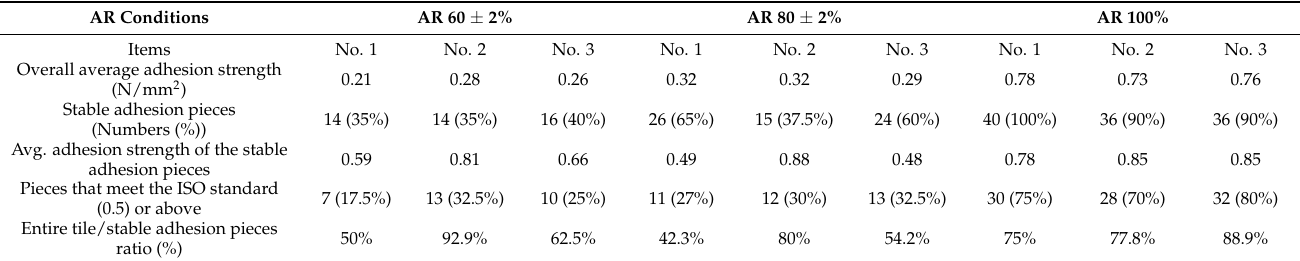
Table 10. Tile specimen evaluation analysis result.